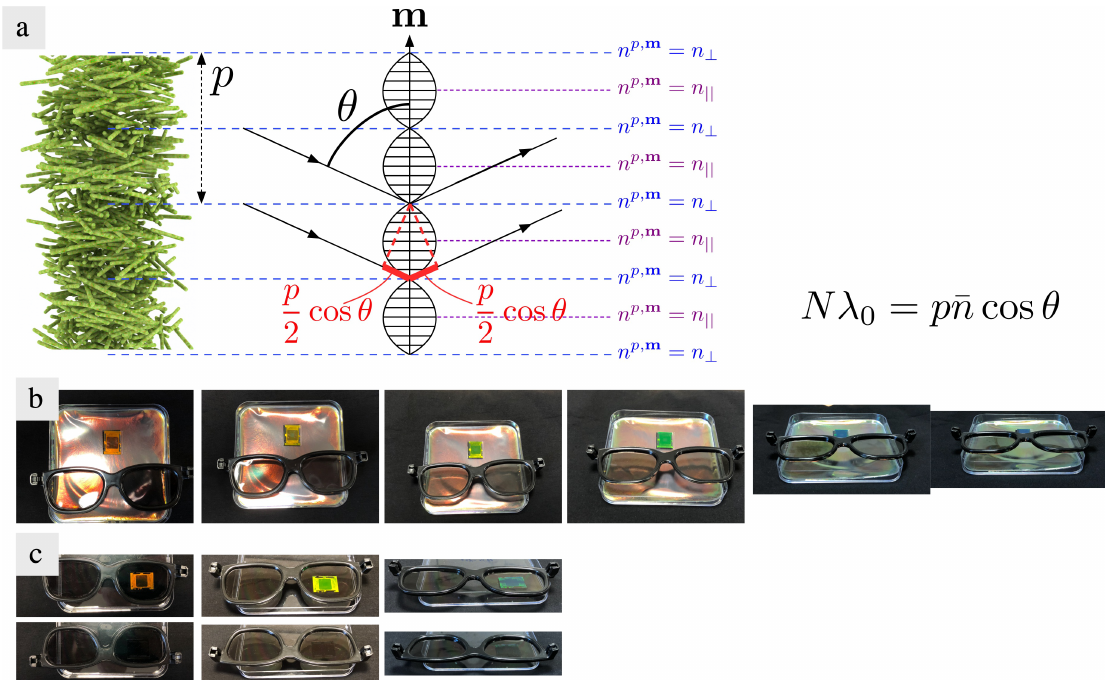
Figure 10. Illustration of visible Bragg reflection from cholesteric structures. ( a ) Schematic illustration of how the helical modulation of the director, and thereby the optic axis, gives rise to angle-dependent Bragg reflection. On the left, a realistic depiction of rods in a cholesteric arrangement is shown. Next to it a commonly used simplified representation is drawn, where a long horizontal line represents n in the paper plane whereas a vanishing line means that n is perpendicular. If we consider light incident along the helix axis m with polarization in the paper plane (p) it will experience a refractive index n p , m that varies with a period of p /2 between n ⊥ and n || , as indicated on the right. If we instead consider light entering at an oblique angle θ with respect to m , we can apply Bragg’s simplification and consider that light is reflected every time the refractive index repeats itself, for instance being n ⊥ as in the figure. The two drawn light rays reflected at different levels along m , separated by p /2 from each other, will then have slightly different path lengths, as indicated in red. In order to get constructive interference, the difference must be an integer N times the wavelength, i.e., we obtain Bragg’s condition N λ 0 = p ¯ n cos θ , where λ 0 is the central reflection wavelength as measured in air and ¯ n is the average refractive index (see main text). ( b ) Viewing angle-dependent selective reflection of a large square dried CNC film (11.5 cm side length) and a small cell containing a thermotropic cholesteric. The CNC film is viewed partially through 3D cinema glasses, thus through a left-handed circular polarizer on the left and a right-handed one on the right. For normal incidence the reflected light is left-handed circularly polarized but with increasing viewing angle the circular polarization is lost. The color is blue-shifted, i.e., λ 0 moves to shorter values, as expected for increasing θ . ( c ) For comparison, the thermotropic sample is viewed through the right and left circular polarizers under identical illumination and imaging conditions as a function of viewing angle. The circular polarization (here right-handed) is retained even for a large θ